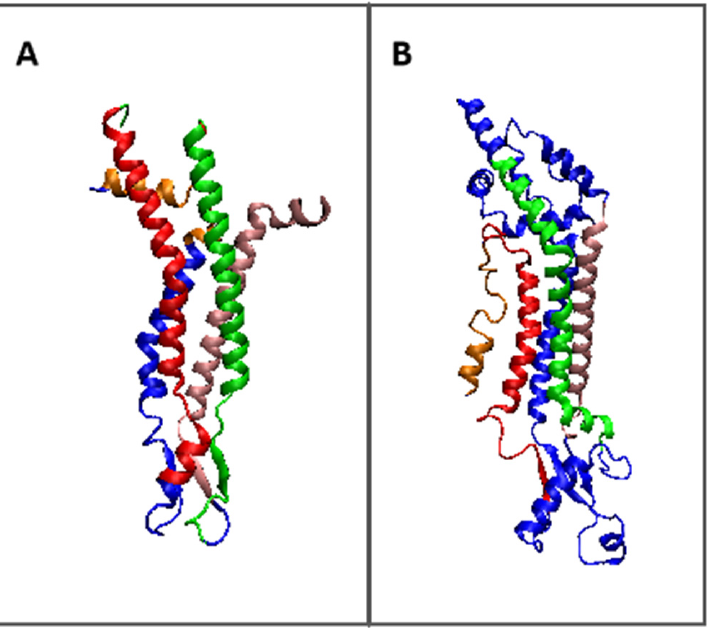
Figure 6. 3D presentation showing the analogous fragments in the chain treated as individual structural units: ( A )—connexin, ( B )—pannexin. Colors as given in Table 2 and Figure 5. Table 2. Comparison of RD and K values for analogous sections determined on the basis of similar- ity of Figure 5 . D Gauss function spanned on a single chain) and on the basis of T profiles for chains representing complexes (all chains in the complex represent the same status). 3D Gauss function spanning the entire complex.